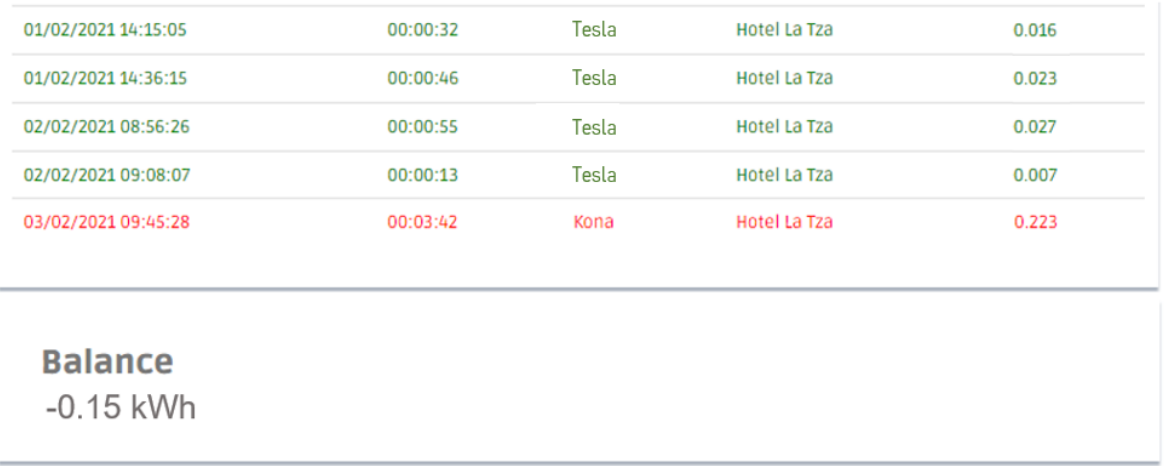
Figure 20. The web interfance of the Hotel du